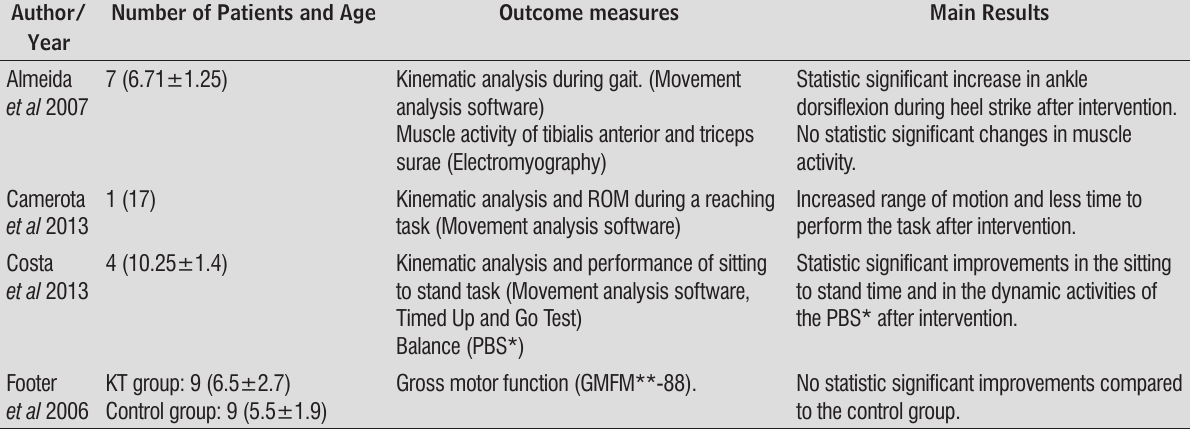
Table 2 - Patient Characteristics, Outcome Measures, and Main